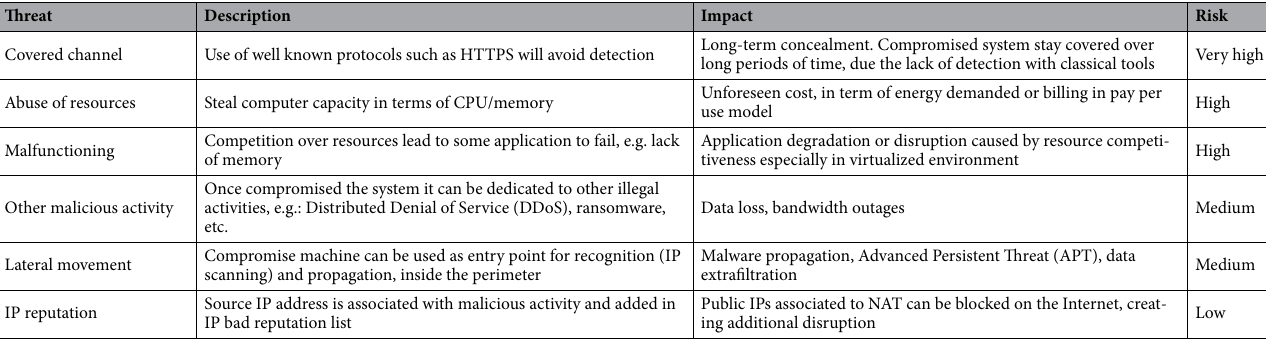
Table 1. Cryptomining attack. Security